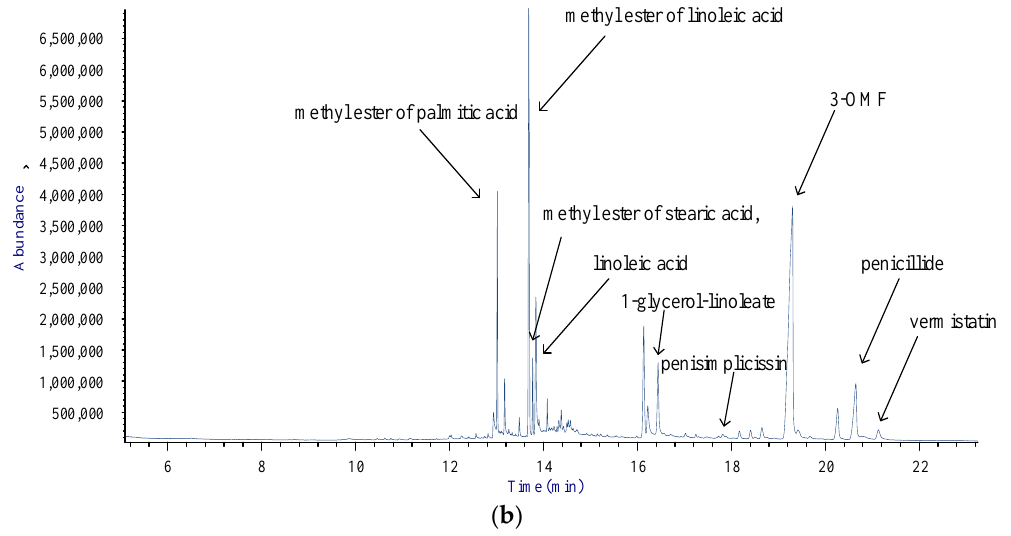
Figure 2. Annotated total ion chromatograms (TICs) acquired by: culture filtrate extract ( a ); and mycelial extract ( b ) of T. pinophylus .